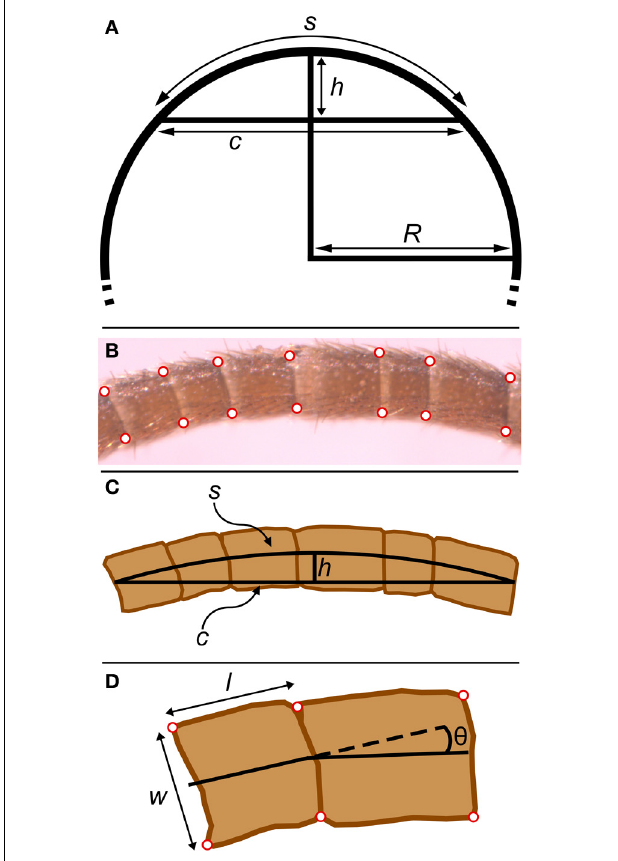
FIGURE 5 | Geometrical parameters in bent antennae. (A) The relationship between chord ( c ), arc length ( s ), sagitta ( h ), and radius ( R ) in a circle. The sagitta is the line segment that starts at the center of the chord, is orthogonal to the chord, and terminates where it intersects with the circle. (B) Micrograph of bent antenna with corners digitized. (C) Equivalent geometrical features for the experimental part of a bent flagellum. The chord ( c ) was approximated as the line segment joining the two terminal midpoints of the experimental section of the flagellum. The radius of curvature ( R ) was calculated from the chord ( c ) and sagitta ( h ) as explained in the text. (D) The four corners of each flagellomere (red) were digitized. Lengths ( l ) and widths ( w ) for all flagellomeres were calculated from these points. The angle between adjacent flagellomeres was calculated from the angle between line segments connecting the midpoints of the digitized